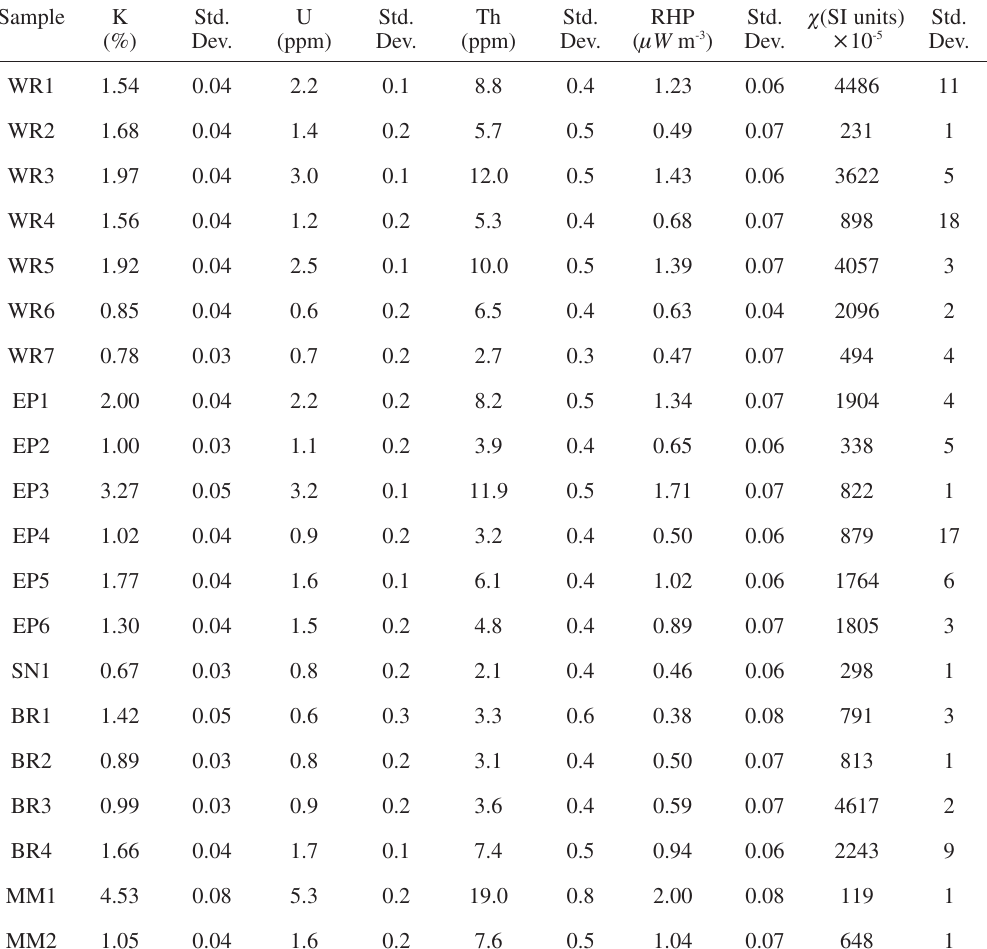
Table III. Concentration of the heat-producing elements (U, Th, K), radioactive heat-production rate (RHP) and magnetic susceptibility ( χ ). Sample K Std. U Std. Th